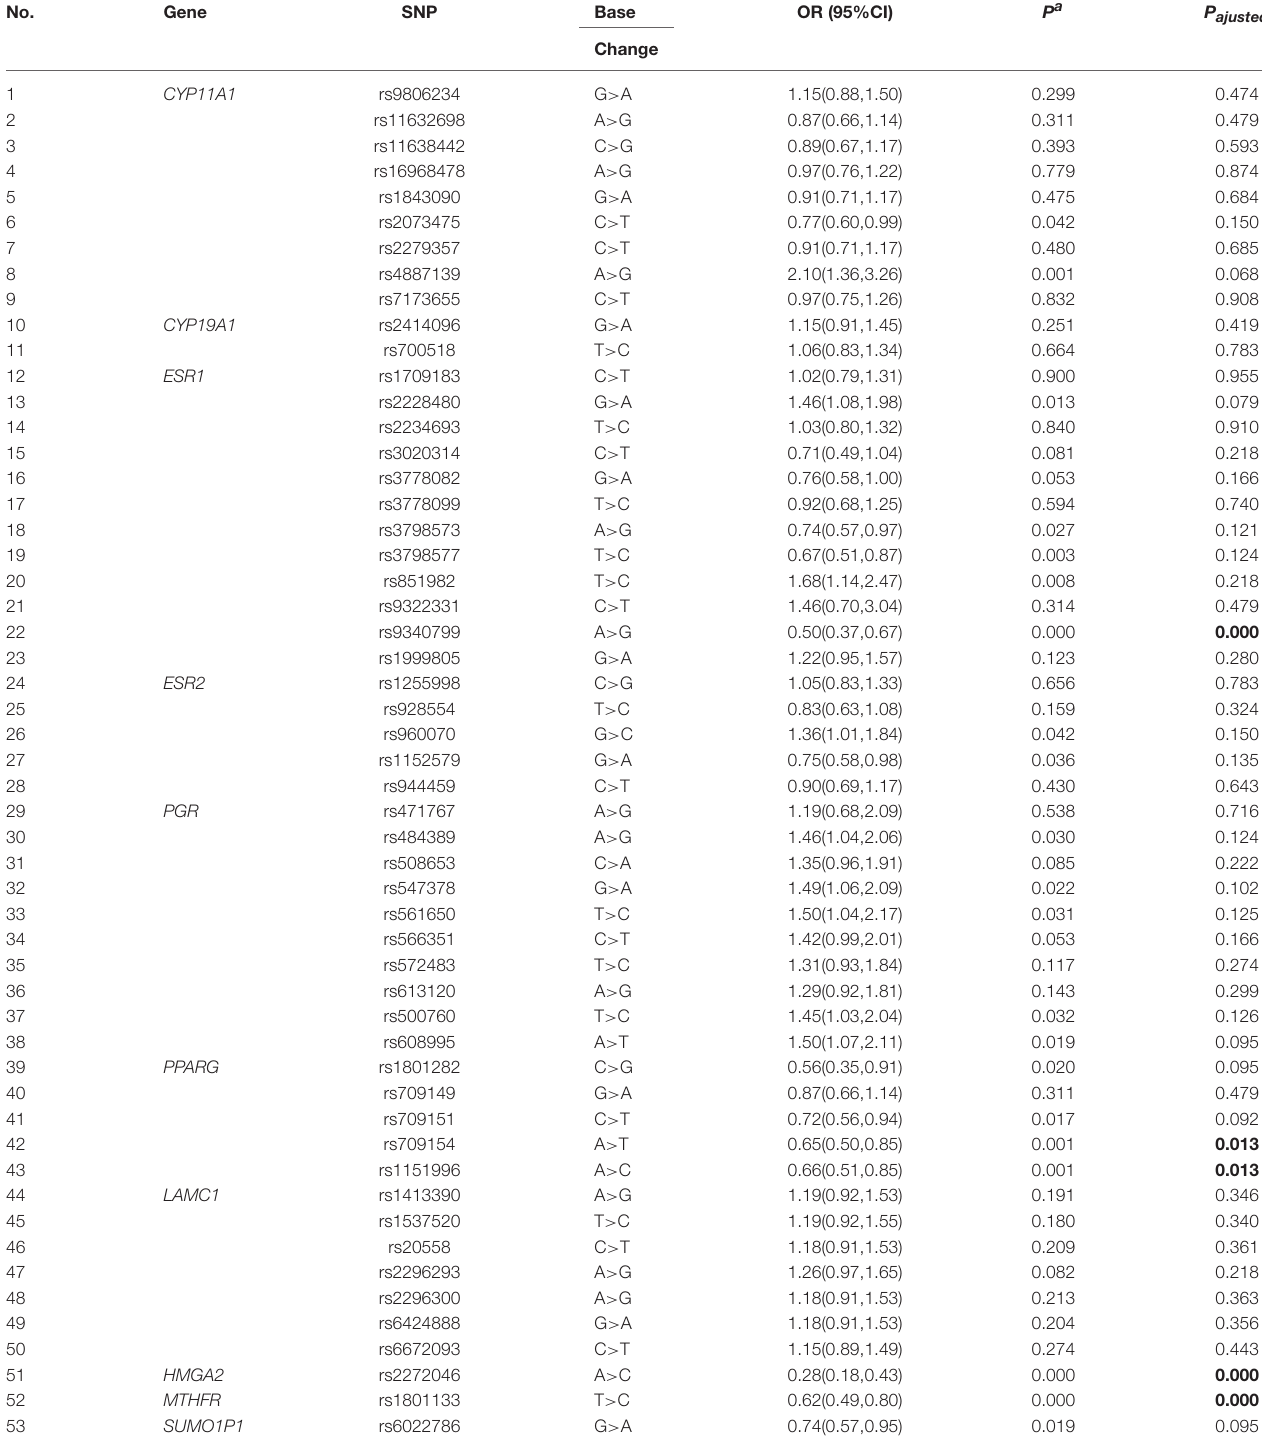
TABLE 3 | Allele frequencies of the selected genetic variants analyzed in PCOS patients and controls.